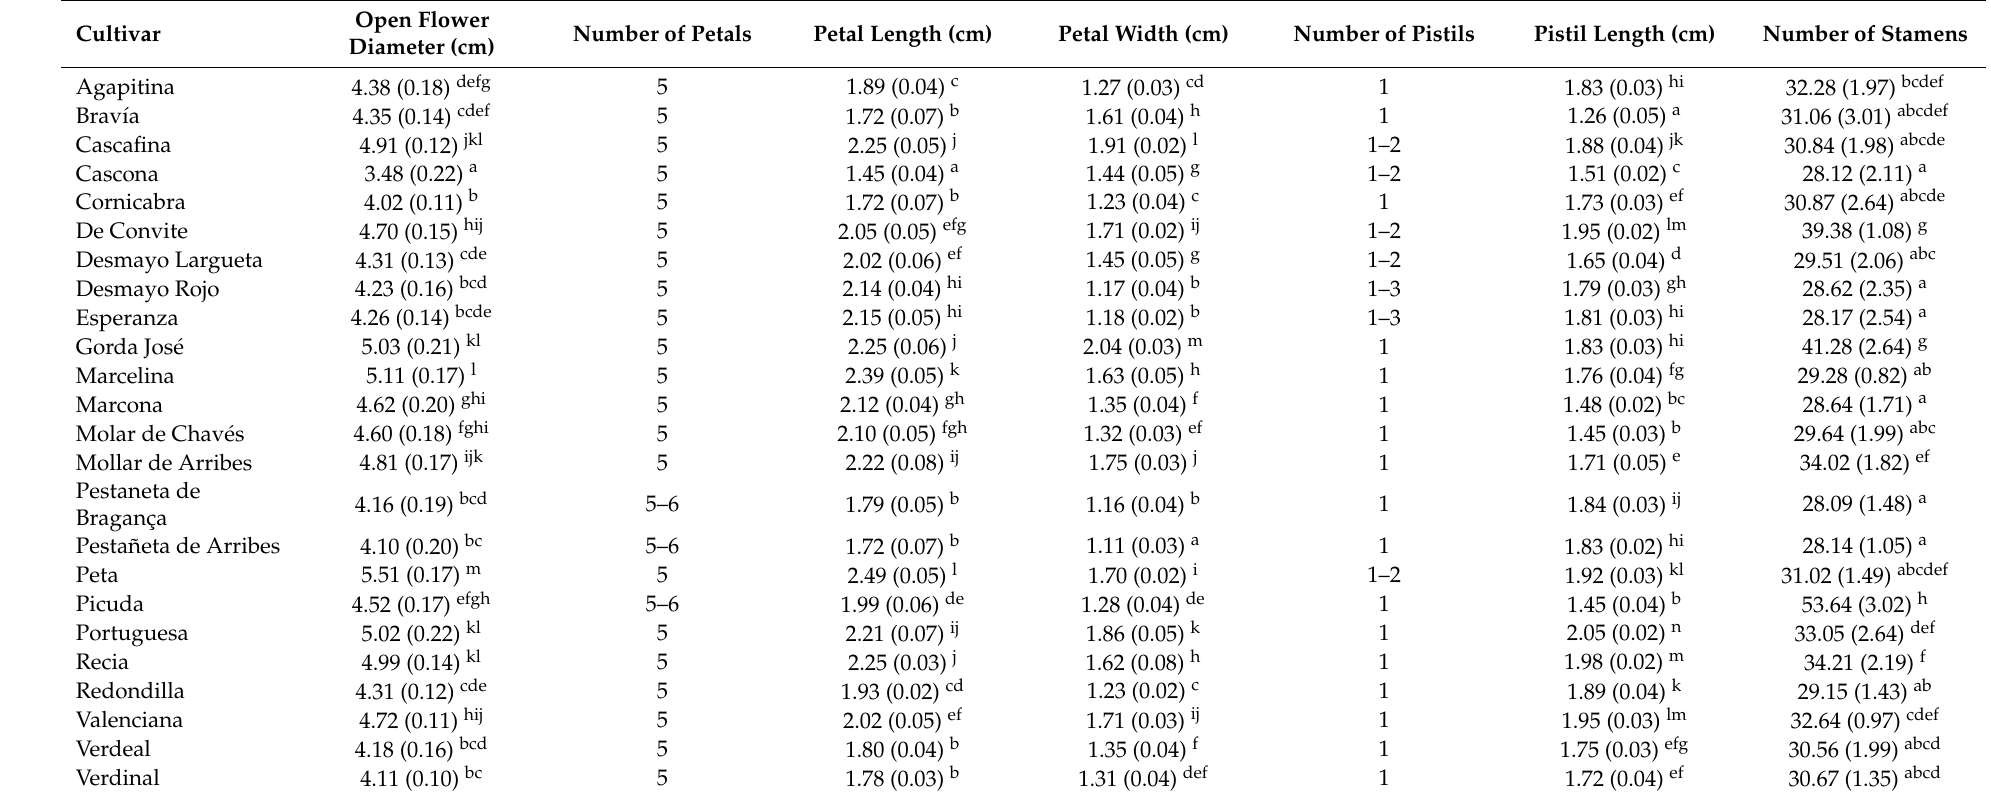
Table 1. Means, standard deviations and ANOVA analyses for some flower parameters in almond